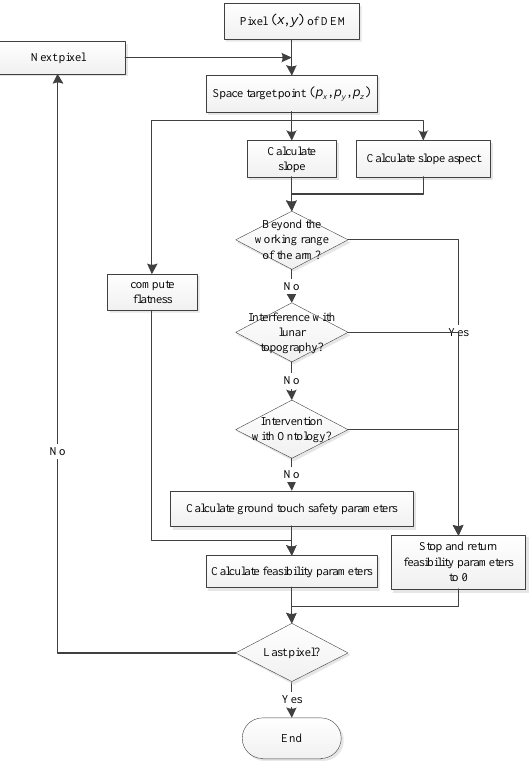
Figure 8. Flow chart for calculating topographic feasibility Using the simulated lunar sampling DEM image (as shown in Figure 9), the admissibility image generated by the method